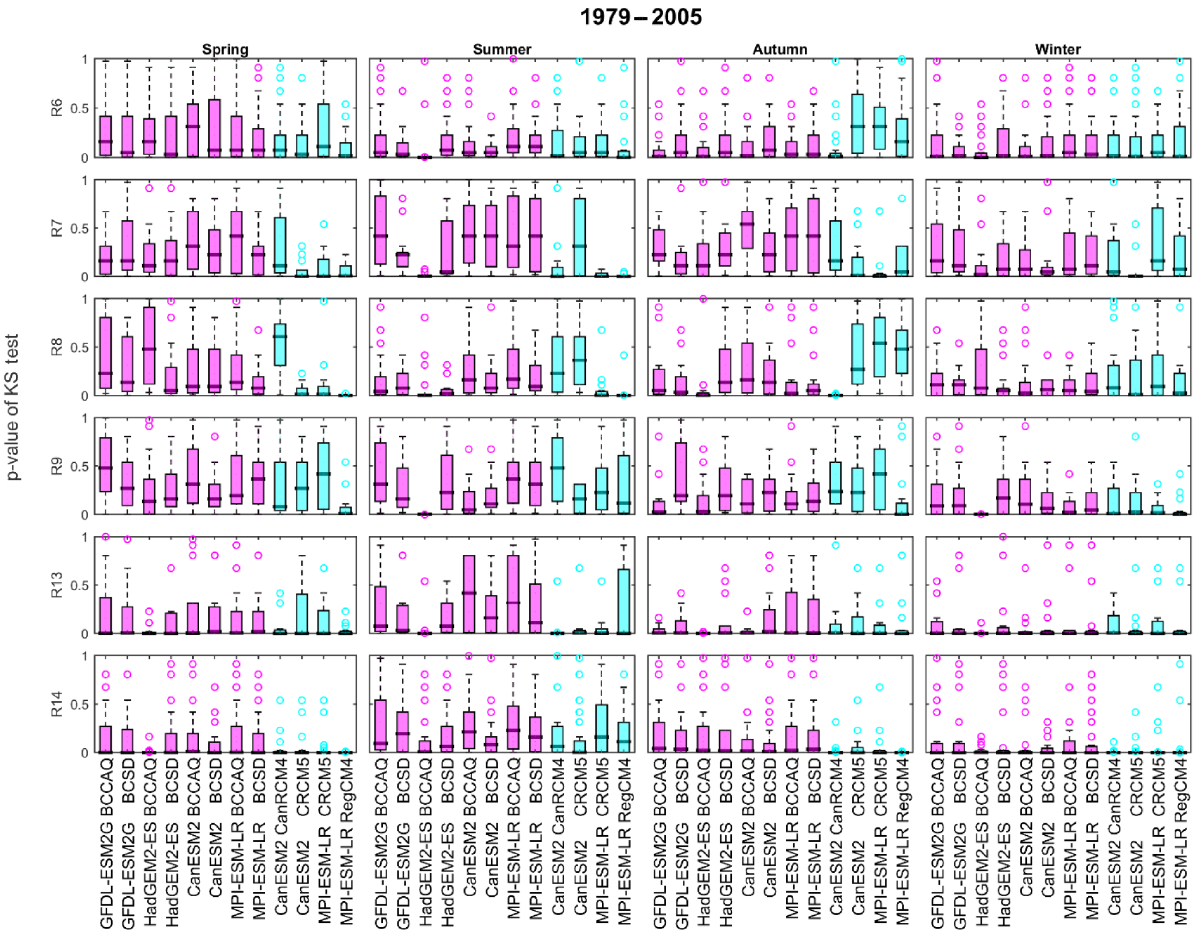
Figure 5. Distributions of p value of the K–S test in four seasons for the period of 1979 to 2005 (long-term comparison of PCIC and NA- CORDEX). Note that the numbers of precipitation-gauge stations in each ecozone are different (see Table 4). The p values of regions 6 to 9, and 13 to 14 (R6–R9, and R13–R14), which are more than or equal to 10 stations, were only shown for illustration in box-and-whisker plots with bottom, band (black thick line), and top of the box indicating the 25th, 50th (median), and 75th percentiles